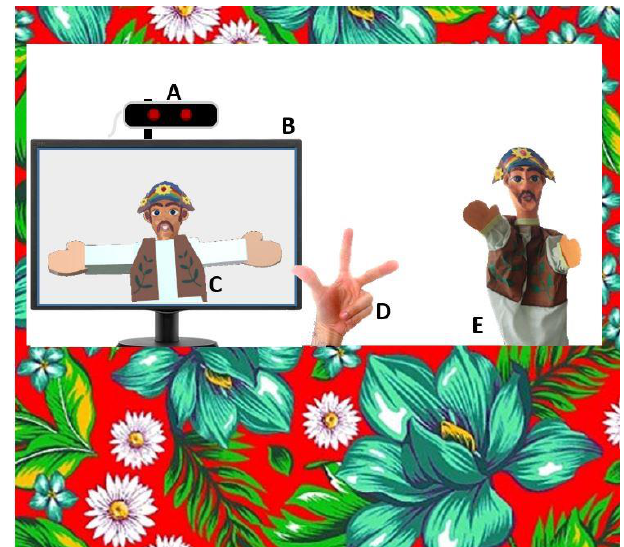
Figure 14. Tent’s layout: A) Leap Motion; B) LCD monitor; C) Virtual Puppet; D) Virtual Puppet handler’s hands; E) Real